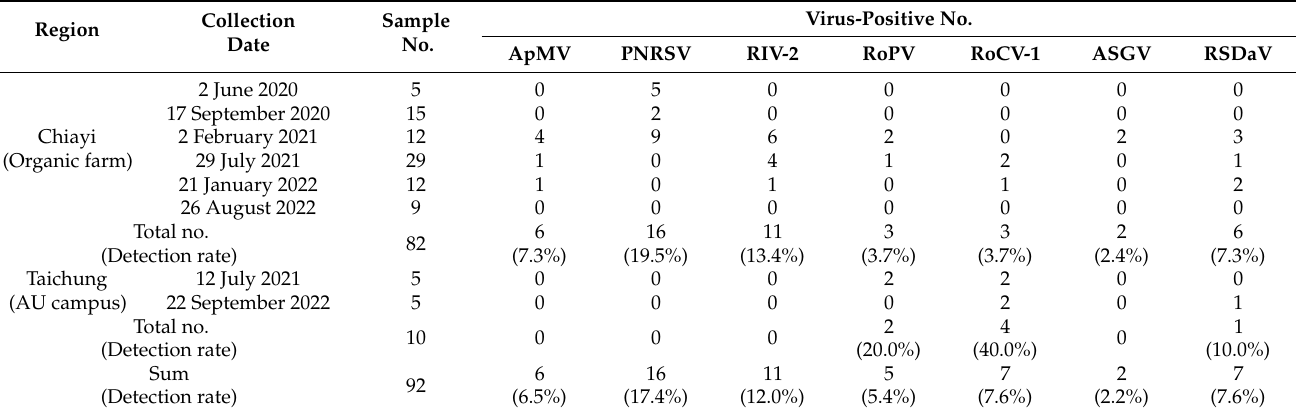
Table 3. Field survey results of rose viruses in central